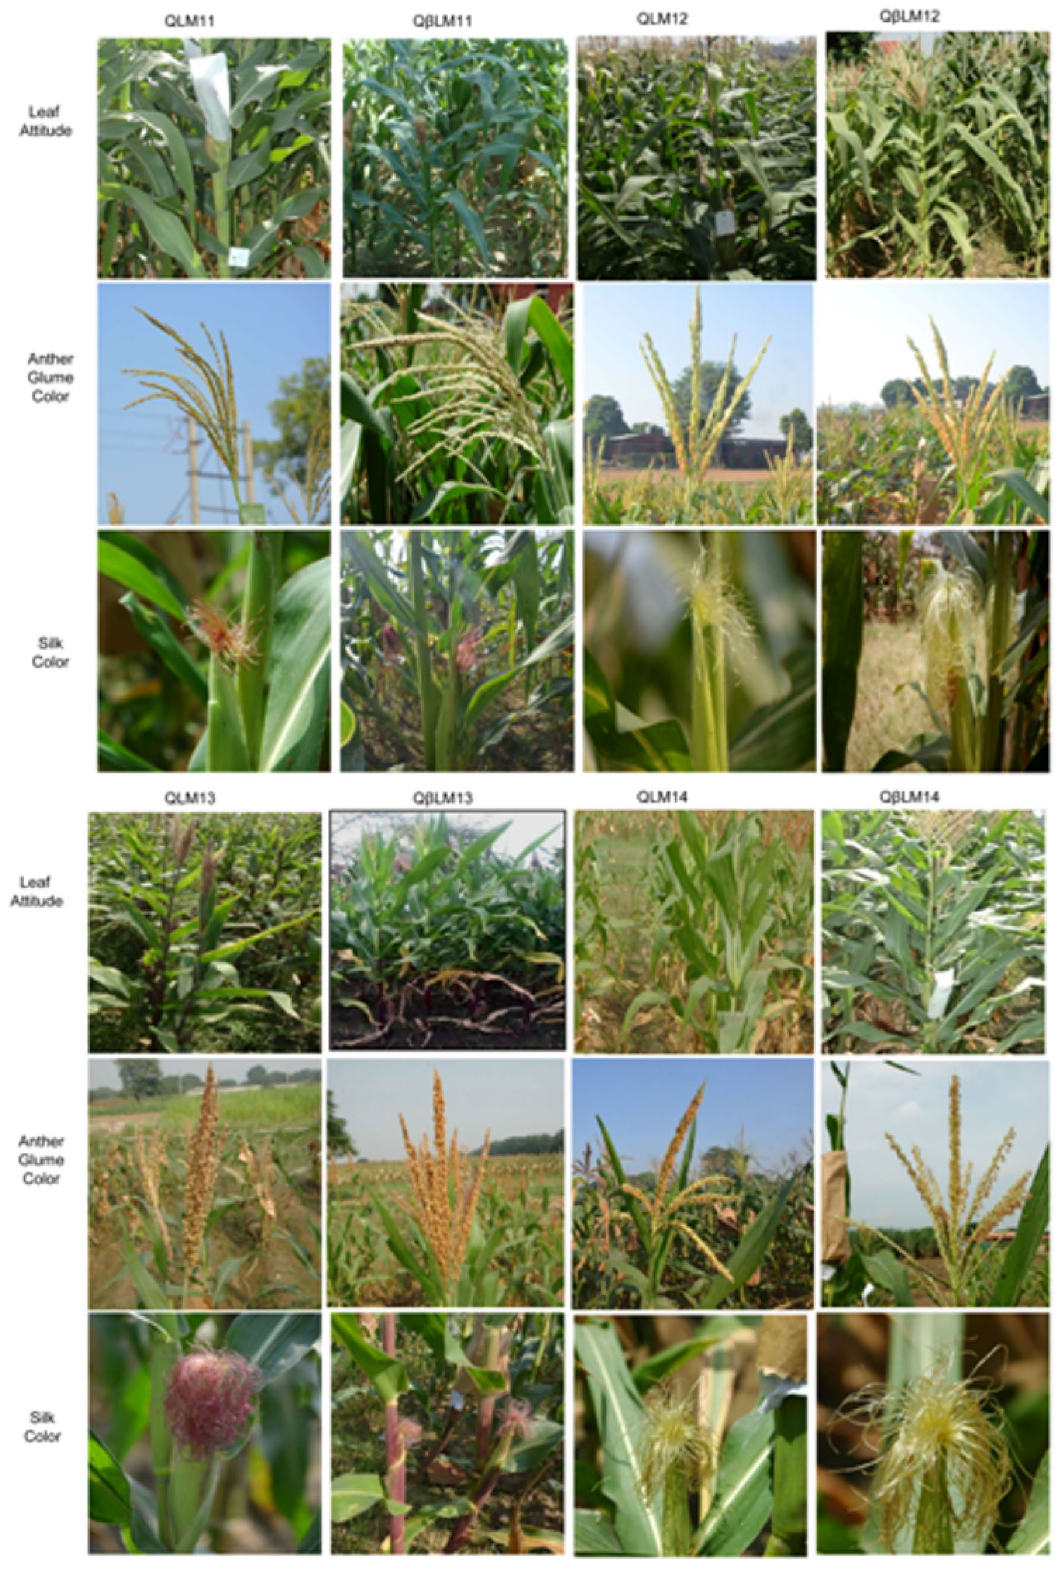
Figure 3. Comparison of morphological traits of the recurrent parents’ vis-à-vis derived introgressed progenies across four